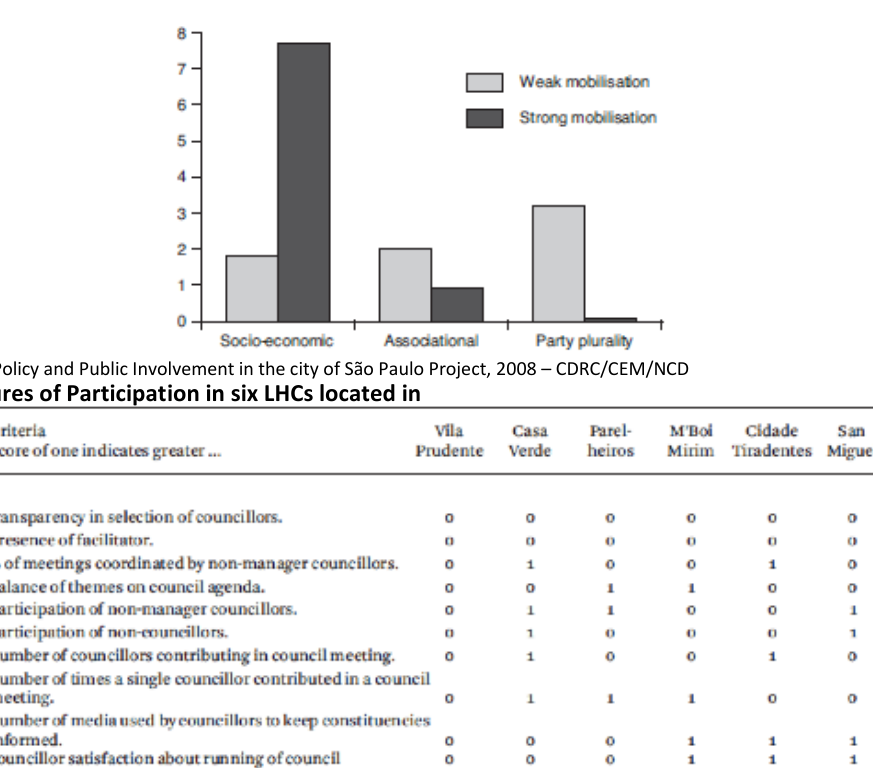
Graf. 1 - Types of inclusion in six LHCs located in areas with different histories of mobilization